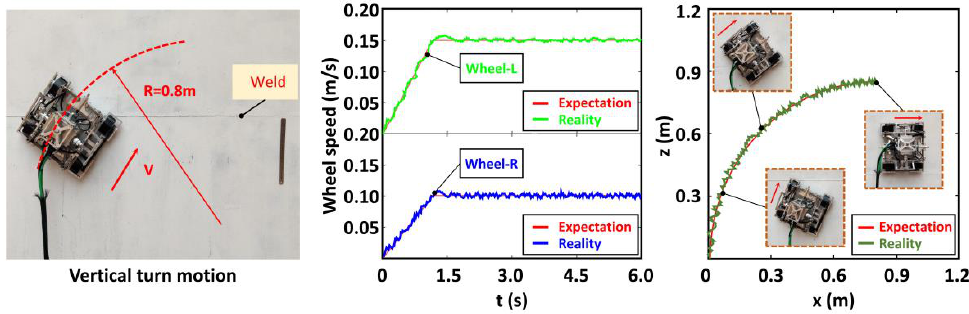
Figure 13. Turn motion test from vertical to horizontal.